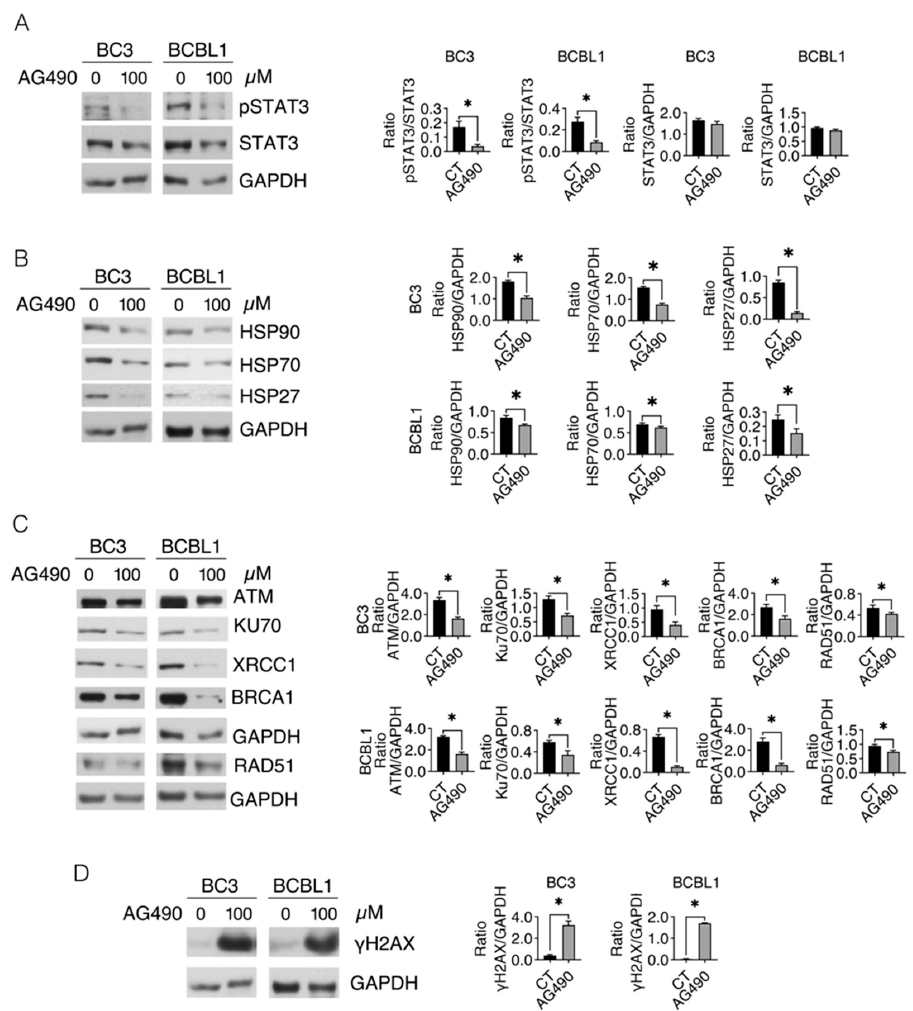
Figure 4. STAT3 inhibition downregulates HSPs and DDR expression and induces DNA damage in PEL cells. BC3 and BCBL1 cell lines were treated with AG490 (100 µ M) for 24 h and ( A ) protein phosphorylation of STAT3 was evaluated by Western blot analysis. GAPDH was used as a loading control and one representative experiment is shown. The histograms represent the densitometric analysis of the ratio of specific protein/GAPDH. Data are represented as the mean plus S.D. p value: * <0.05. ( B ) Protein expression levels of HSP27, HSP70 and HSP90 were evaluated by Western